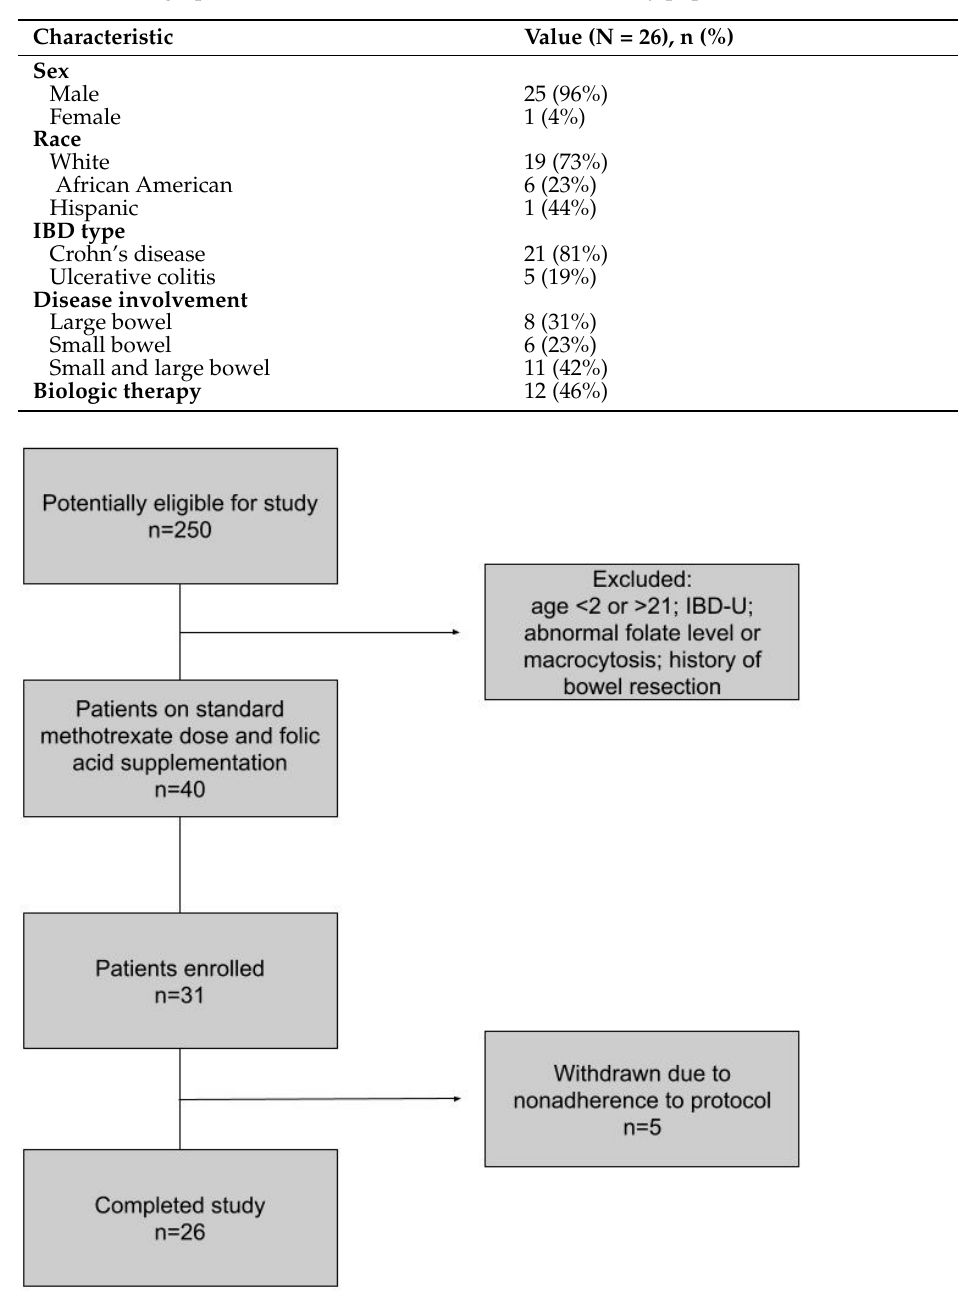
Figure 1. Flowchart of the study. Table 1. Demographics and selected clinical features of the study population.